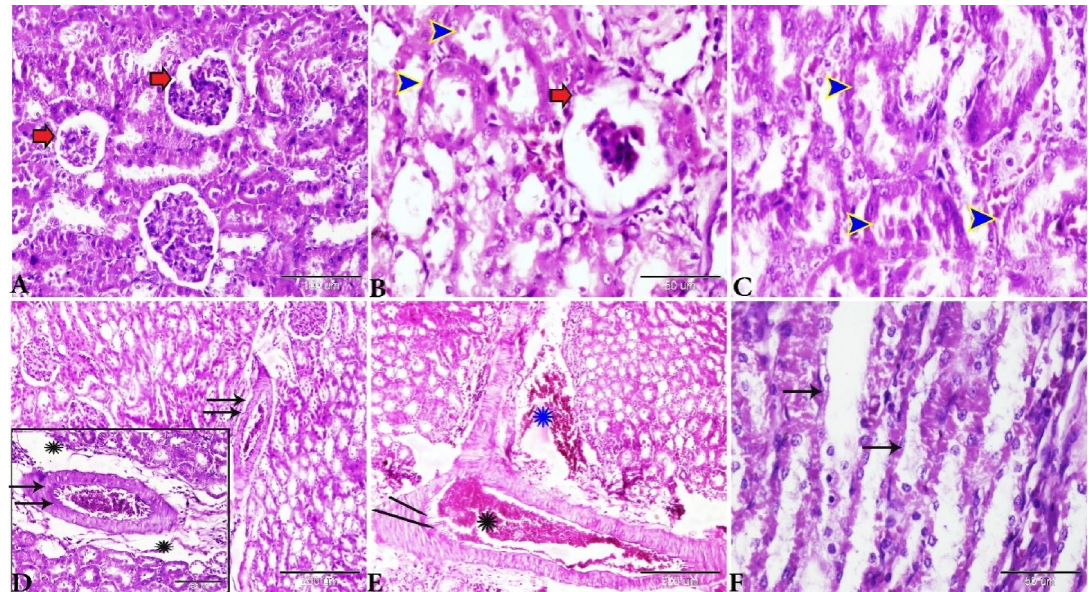
Figure 4. Photomicrograph of the rat kidneys of Group III (treated with basal diet 70% + cheese containing L. helveticus 30%). ( A ) Glomerular atrophy (red arrows). ( B ) Some areas showing severe atrophy and loss of glomerulus with degenerated renal corpuscle (red arrow). ( B , C ) Renal tubular degeneration and desquamation of its epithelial lining (blue arrows). ( D ) The arcuate artery at corticomedullary junction showing congestion (arrows) with perivascular edema (stars). ( E ) The arcuate artery showing severe congestion (black star), thick degenerated wall (scales), perivascular hemorrhage and edema (blue star). ( F ) Renal medulla tubules showing severe degeneration and desquamation of its lining epithelium inside its lumen (arrows) with interstitial hemorrhage between the renal tubules. H&E stain, the bar size was indicated under